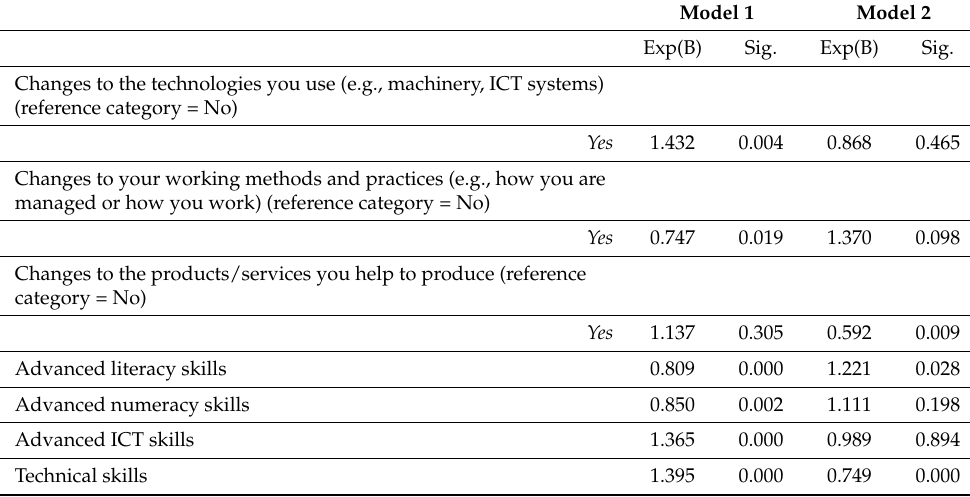
Figure 3. Correspondence analysis between occupation categories and frequency of job autonomy. Source: authors calculation on data from ESJ (Wave 1) [70]. Table 2. Logistic regression for profiling skills needs in science, technology and ICT jobs (Model 1) and teaching positions (Model